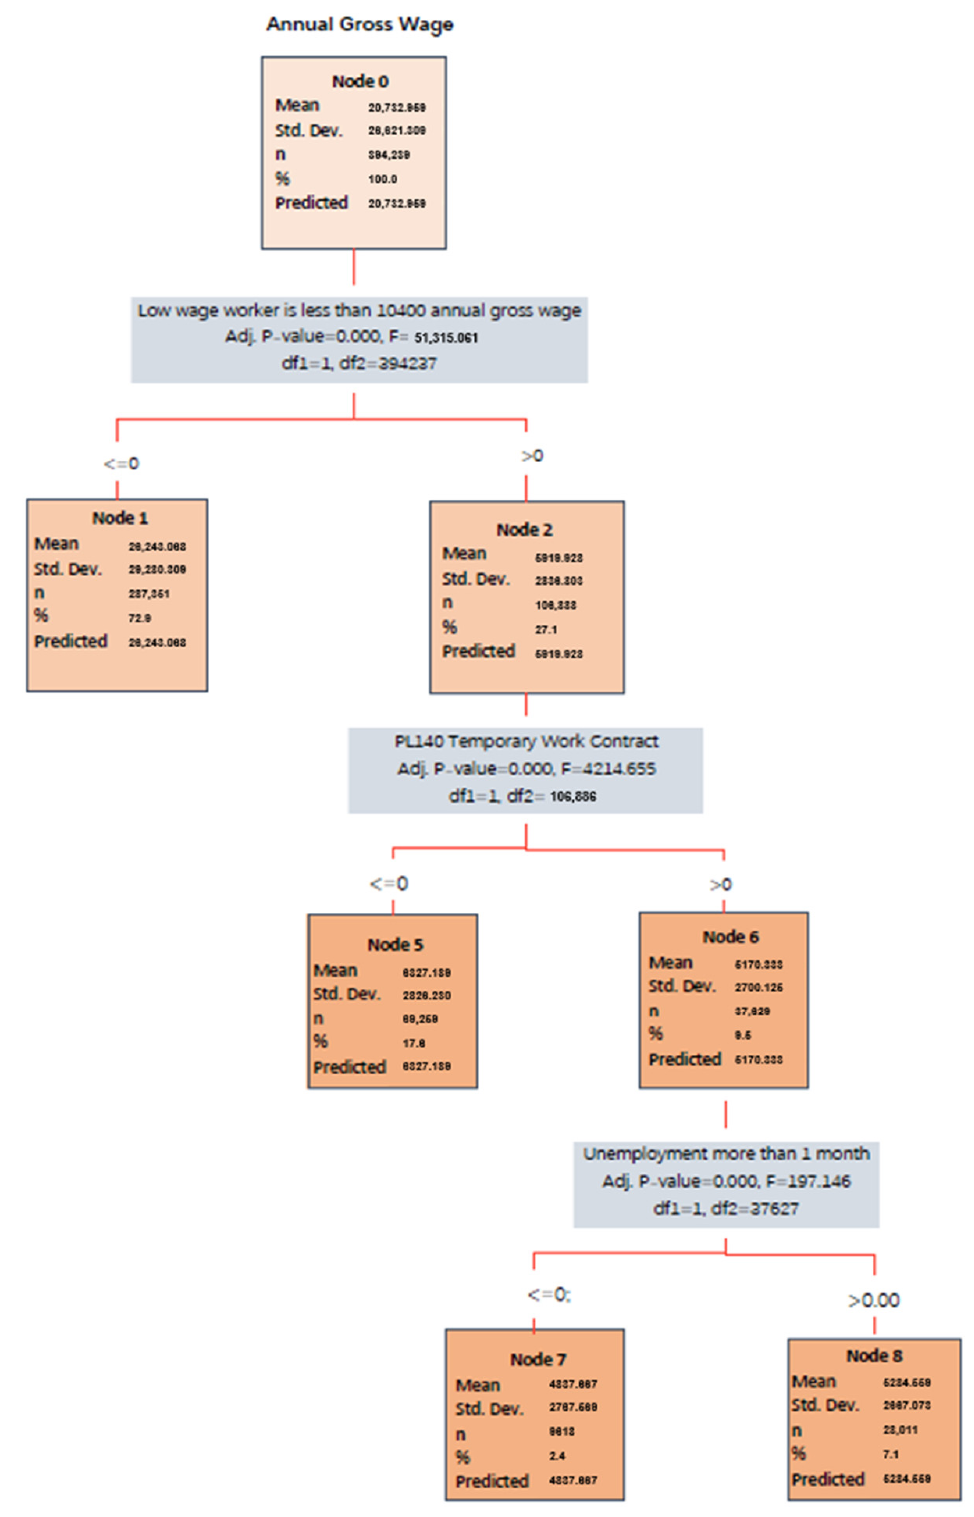
Figure 3. A classification tree for determining the number of precarious of workers in Cyprus and their income. Data source: Eurostat EU-SILC (2020).